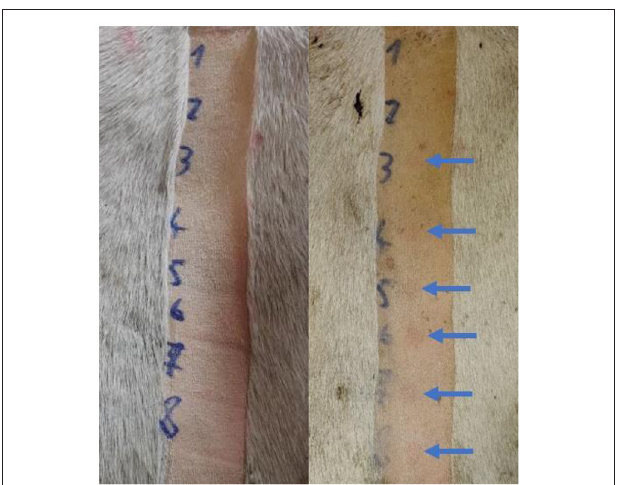
FIGURE 4 | Photograph of the shaved area immediately after irradiation (left) and 24h after irradiation (right). The perceptible erythema is marked with arrows. The third dose was the lowest dose that still produced perceptible erythema. The minimal erythema dose (MED) on shaved skin for this cow was therefore 300 J/m 2 .